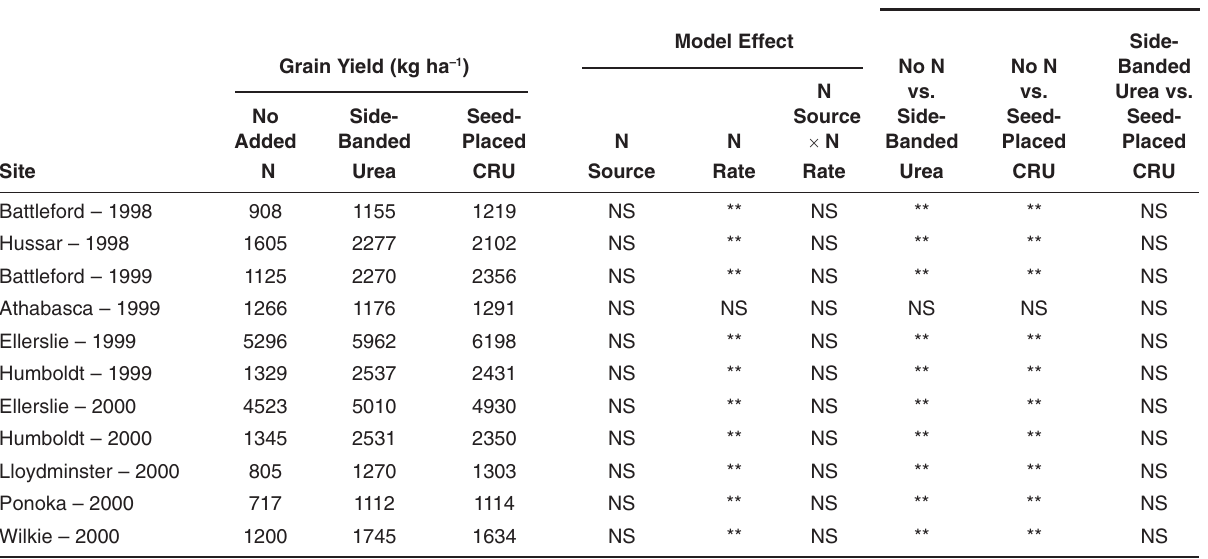
Means of Grain Yield at 11 Sites from 1998 to 2000